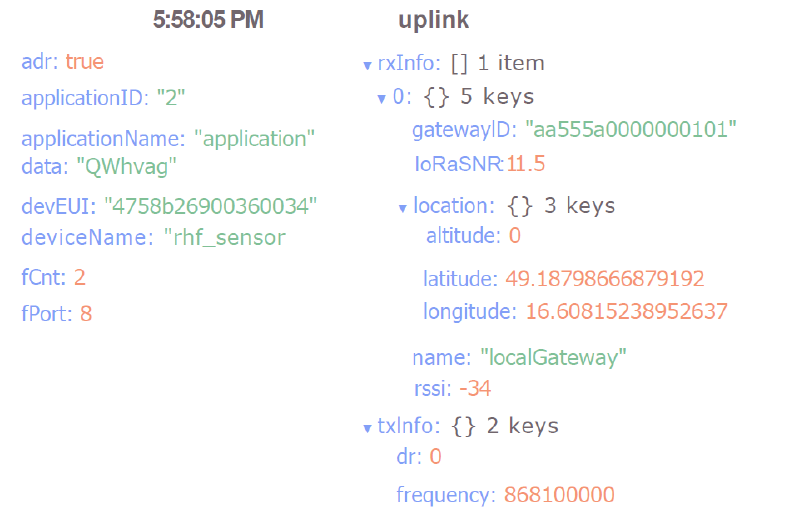
Figure 14. A replay message in the NS